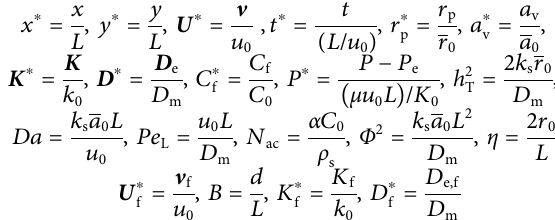
FIGURE 1 | Initial porosity fi